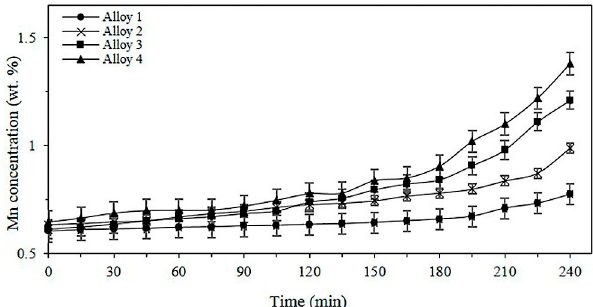
Figure 3. Variation in Mn concentration as a function of the time of the addition of particles from Mn 2 O 3 to 1073 K and 240 rpm of agitation speed, for the indicated alloys.